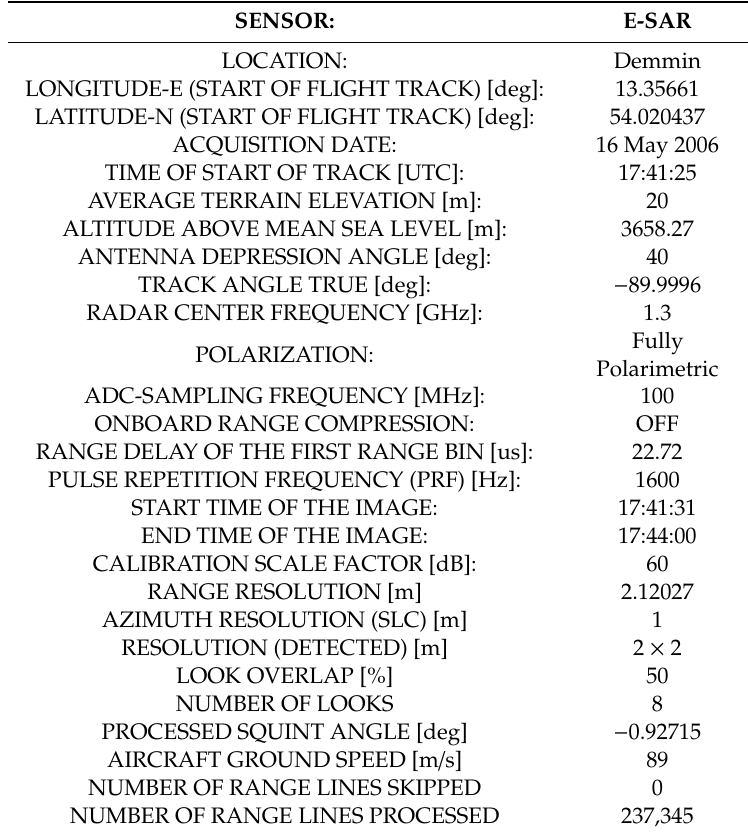
Figure 8. Location of the Gormin farm Test-site (red rectangle) in German federal state Mecklenburg- Western Pomerania. Table 1. E-SAR L-band radar parameters for Demmin scene.